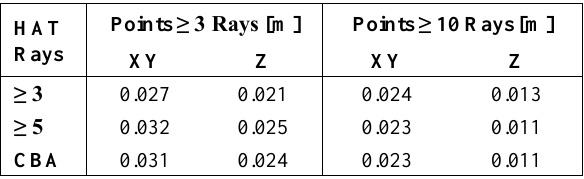
Table 4. Tie point differences (RMS) between the integrated AT and different hierarchical AT runs for the Stillwater block.